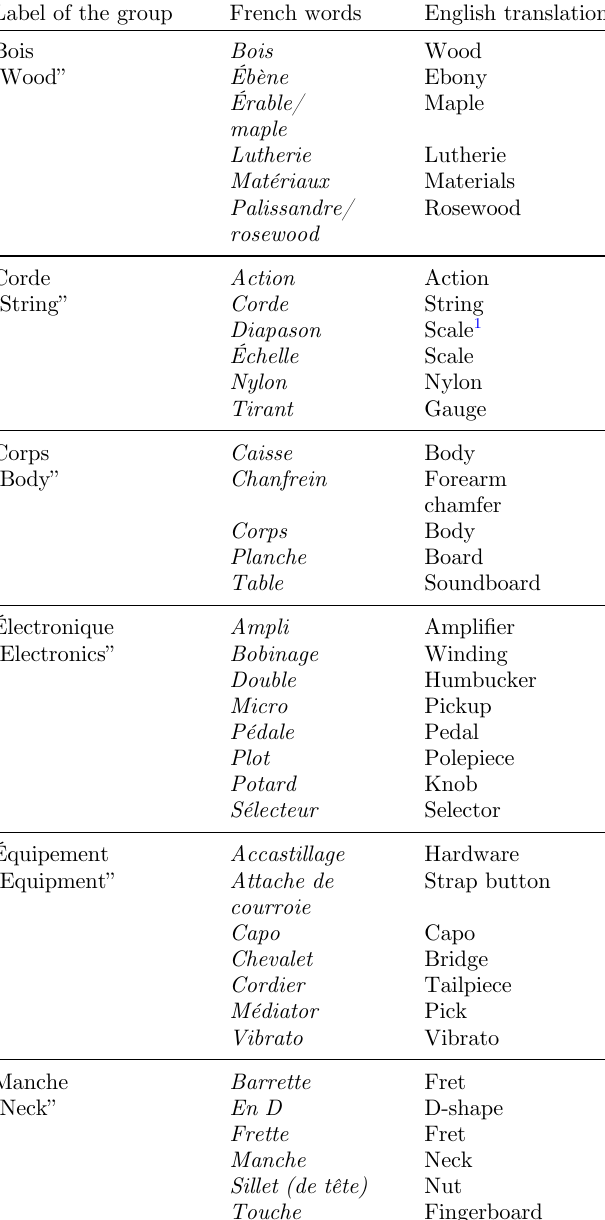
Table 4. Grouping of guitar parts used in the corpus in French with their English